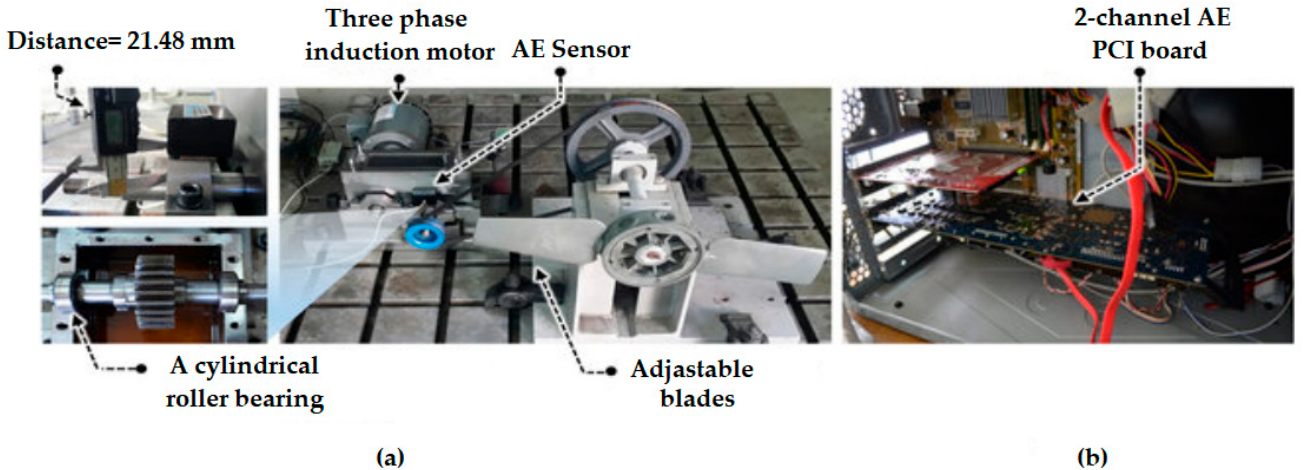
Figure 2. Experimental test for data collection in bearings: ( a ) data generation and ( b ) two-channel acoustic emission PCI board for data acquisition. Table 1. Sensor and data collection system information [9].